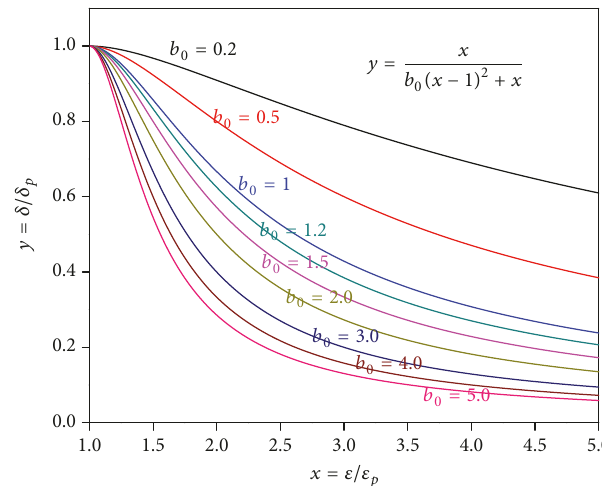
Figure 12: 𝑏 0 and the calculated curve at the descent